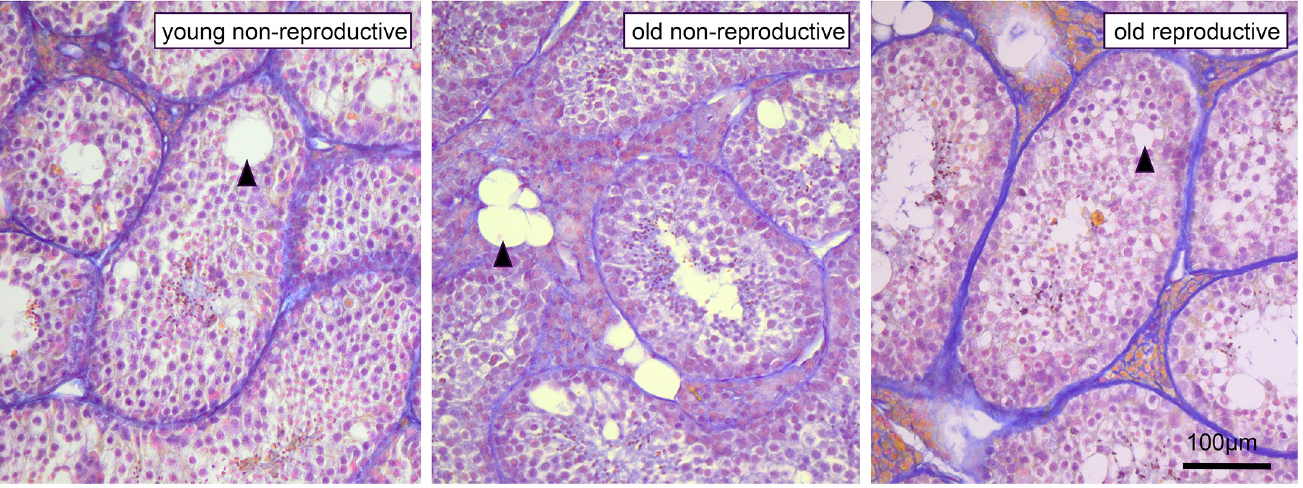
Fig 4. Light microscopy (x200) of histological testicular sections (8 μ m thickness) of three Ansell's mole-rats. A. young non-reproductive (age: 22 months), B. old non-reproductive (age: 8.7 years), C. reproductive male (age: 9.8 years). The germinal epithelium of the seminiferous tubules and to a lesser degree the interstitial testicular tissue of all individuals were characterized by lesions (vacuolar degenerations) exemplarily indicated by black arrowheads.